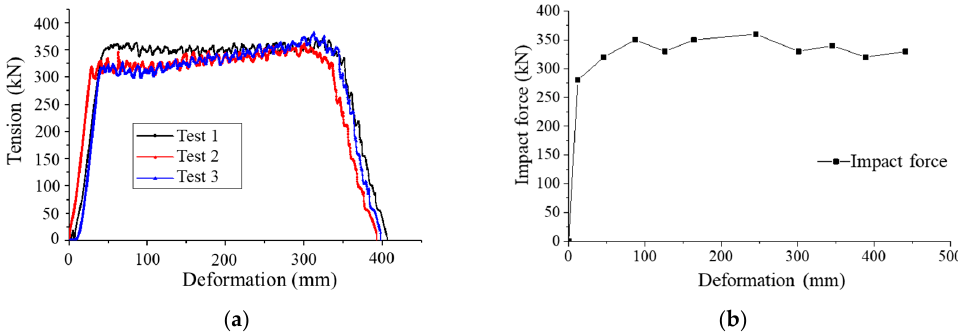
Figure 14. Properties of CRLDA. ( a ) tensile characteristic curve; ( b ) impact force-deformation relation curve.